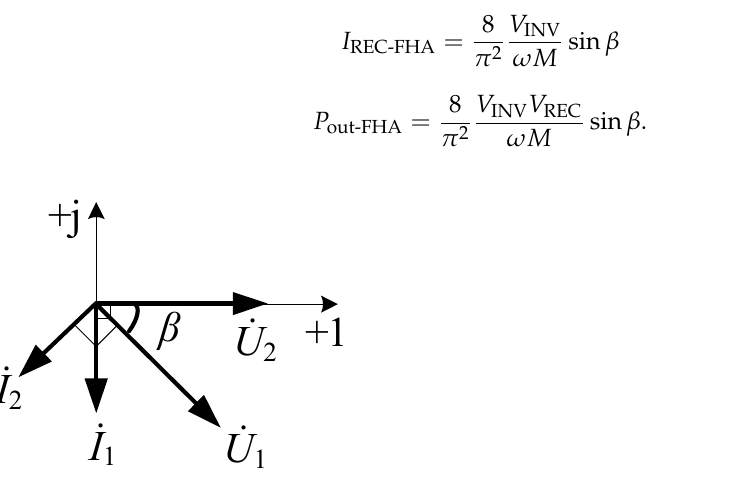
plotted in Figure 3 [11]. The rectifier dc current and the output power can be calculated as